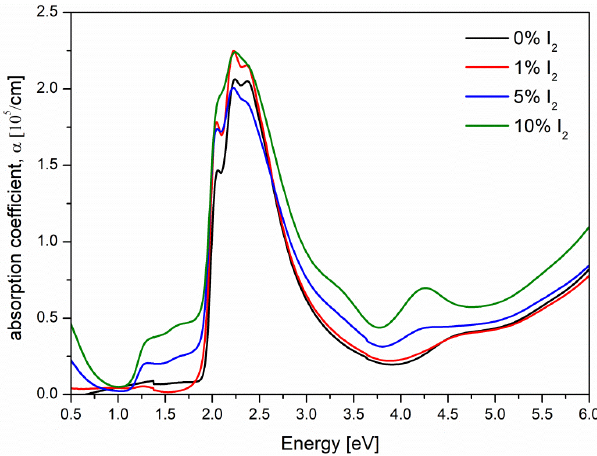
Figure 1. Absorption coefficient spectra, within the whole UV-Vis-NIR spectral range, of P3HT thin films with 0% (black), 1% (red), 5% (blue) and 10% (green) I 2 mol. concentration.